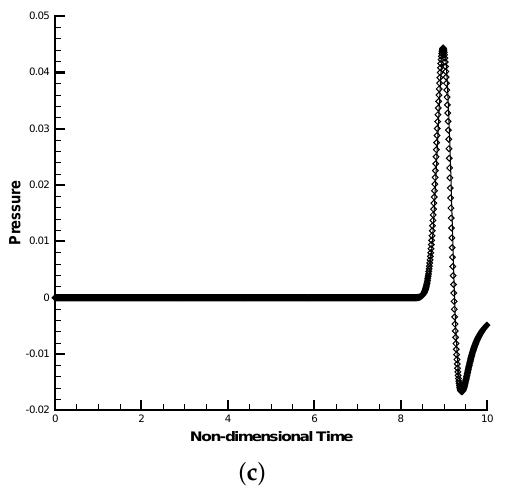
Figure 4. Comparison between computed and analytical pressure signals for acoustic scattering off a 2D cylinder ( ♦ numerical, — analytical). ( a ) Time history of monitor Point A shown in Figure 3; ( b ) Time history of monitor Point B shown in Figure 3; ( c ) Time history of monitor Point C shown in Figure 3.